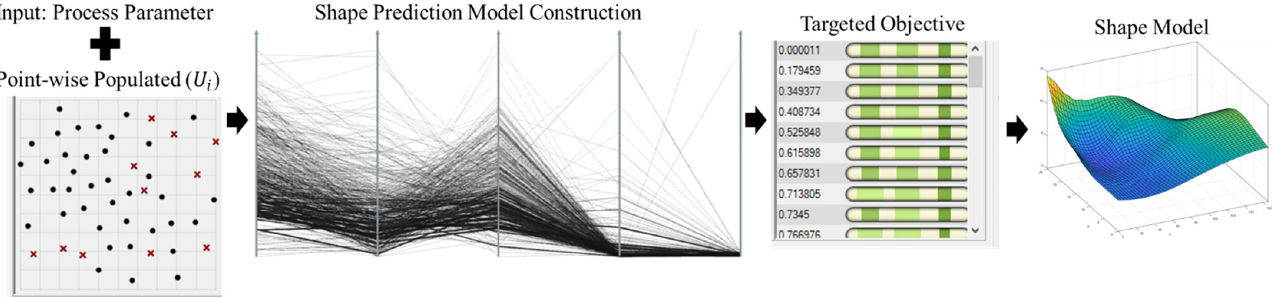
Figure 6. Deposition shape response construction through implemented machine learning framework.